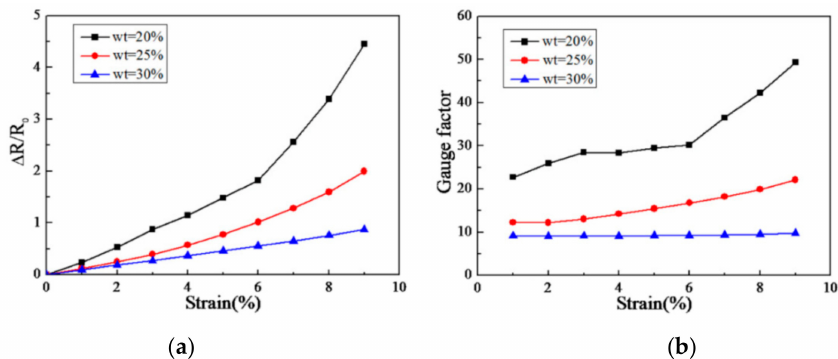
Figure 15. Resistance change with strain for di ff erent concentrations. ( a ) Resistance change with strain; ( b ) Variation of gauge factor with strain. Reproduced with permission from [133]. Copyright 2016, AIP Publishing.